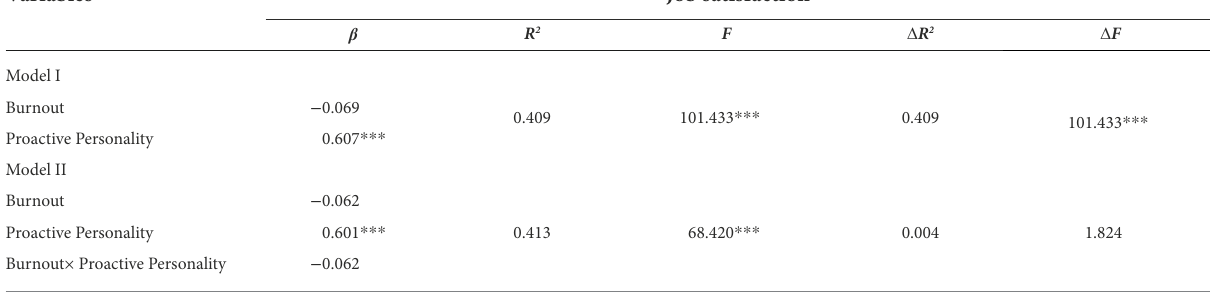
TABLE 6 Hierarchical regression for testing the moderating effect of Proactive Personality (Predicted Variable: Job Satisfaction).